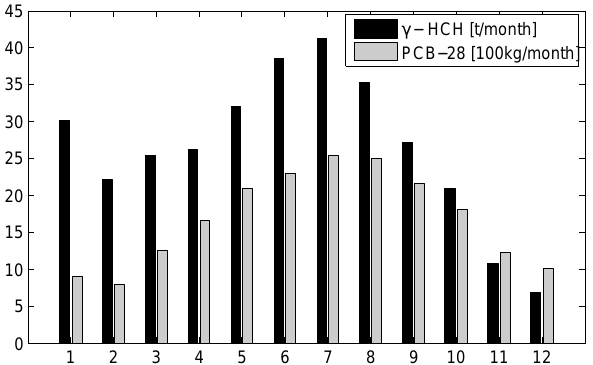
Fig. 2. Monthly average emissions of γ -HCH and PCB-28 inte- grated over a box over Europe (10 ◦ W to 50 ◦ E and north of 20 ◦ N). Note the different units.